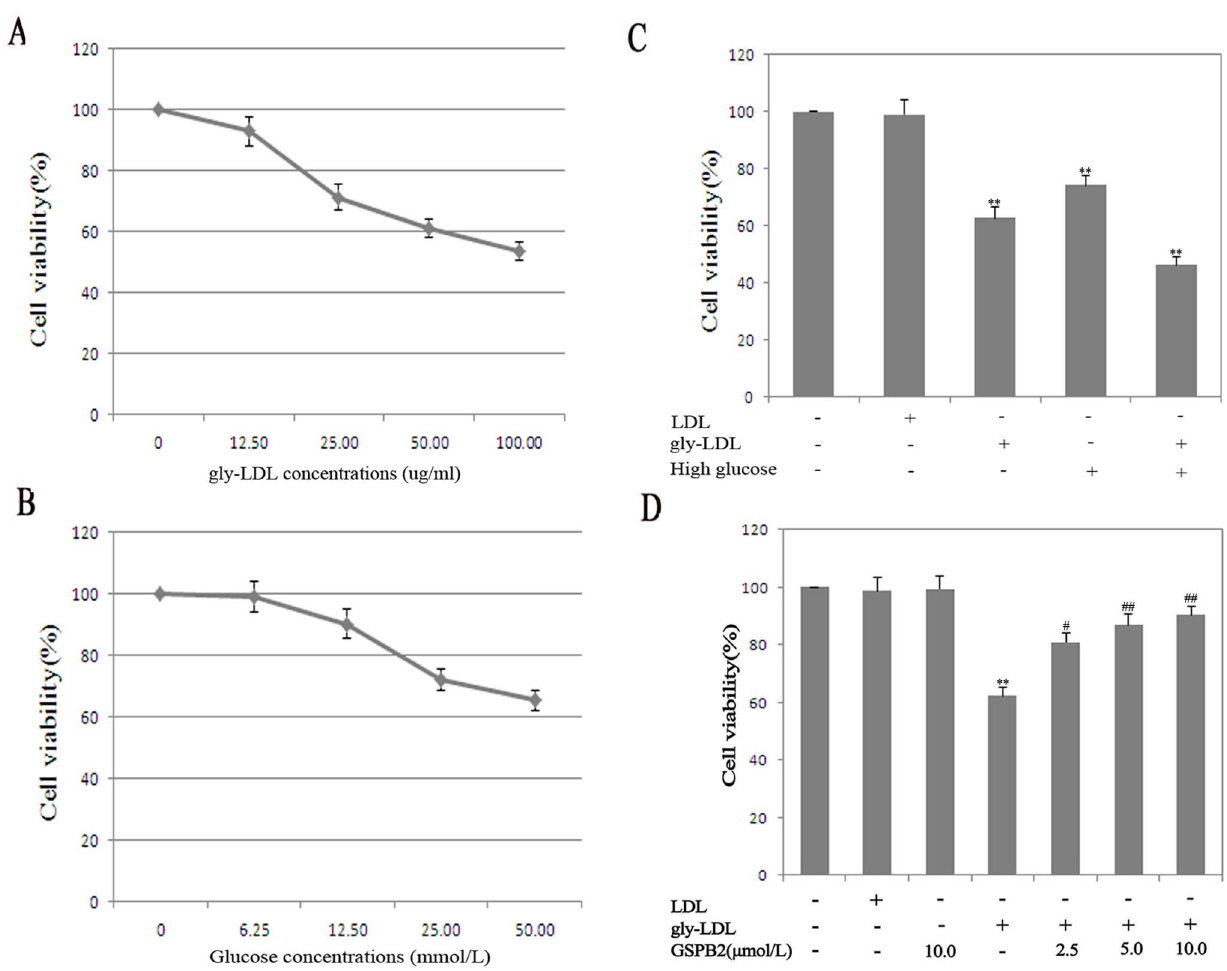
Figure 2. Effects of gly-LDL or high glucose on viability in HUVEC with MTT. A: Effects of different concentrations gly-LDL on viability in HUVEC at 48 h. B: Effects of different concentrations D-glucose on viability in HUVEC at 48 h. C: Effects of gly-LDL (50.00 m g/ml) or/and high glucose (25.00 mmol/L) on viability in HUVEC at 48 h. D: Effects of GSPB2 on viability in HUVEC treated by gly-LDL at 48 h. Results are expressed as percent of untreated cells (100%) and are given as mean 6 SD from five independent experiments. * P , 0.05, ** P , 0.01 compared with CC group; # P , 0.05, ## P , 0.01 compared with gly-LDL group.